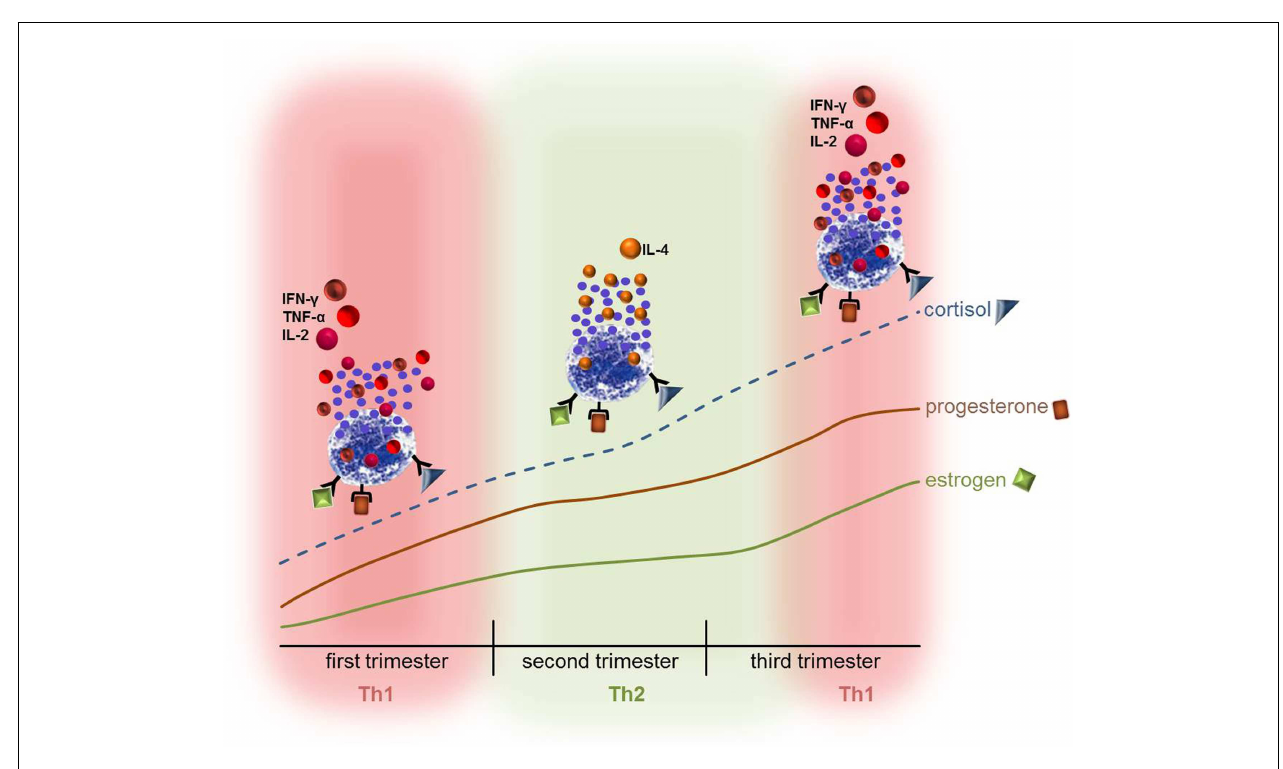
mediators thus contributing to theTh1 orTh2-based micromilieu. Hence, disorders that are mediated by MCs or in which MCs are involved may turn into an unfavorable direction. It is however also possible that the symptoms ameliorate due to the hormone-modulated behavior of